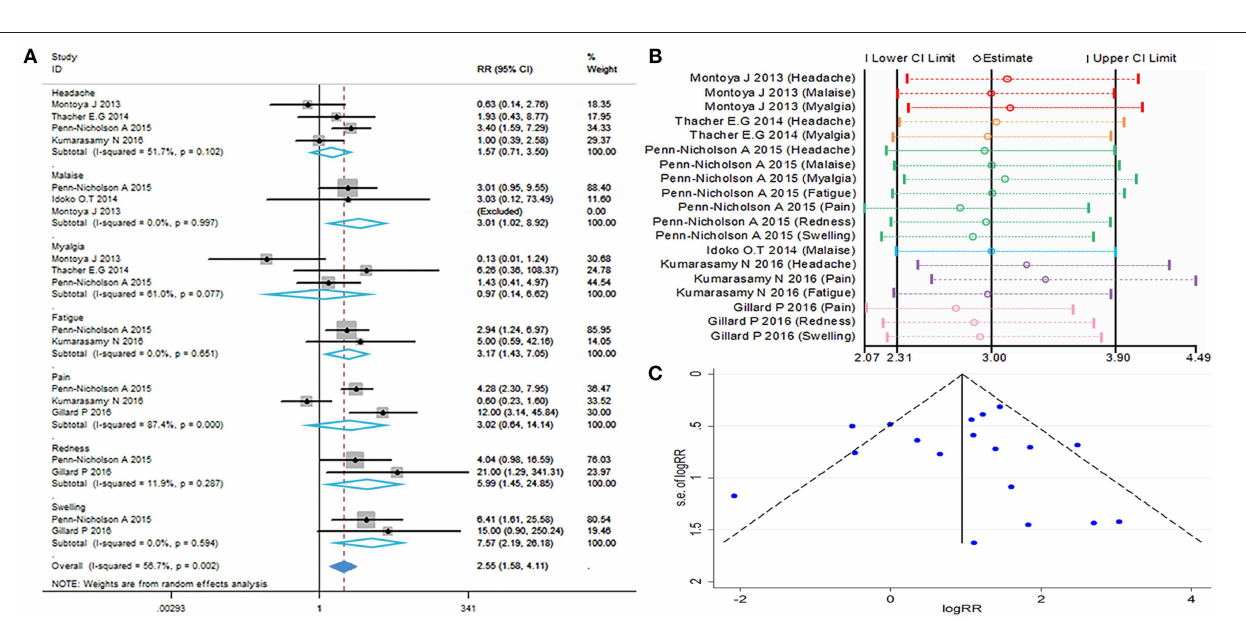
FIGURE 6 | Safety evaluation. (A) Forest plot: a RR > 1 indicates that the vaccine was protective, the result of intersection with the intermediate invalid line was invalid. RR = 1, invalid result. Point estimates and 95%CI are shown for each study and for the pooled results. (B) Influence analysis, examine the impact of a study on the total combined effect. The vertical solid line in the middle indicates the total combined effect, while the left and right vertical solid lines indicate 95%CI. (C) Funnel plot: the publication bias was independently assessed by determining the symmetrical distribution of the studies.